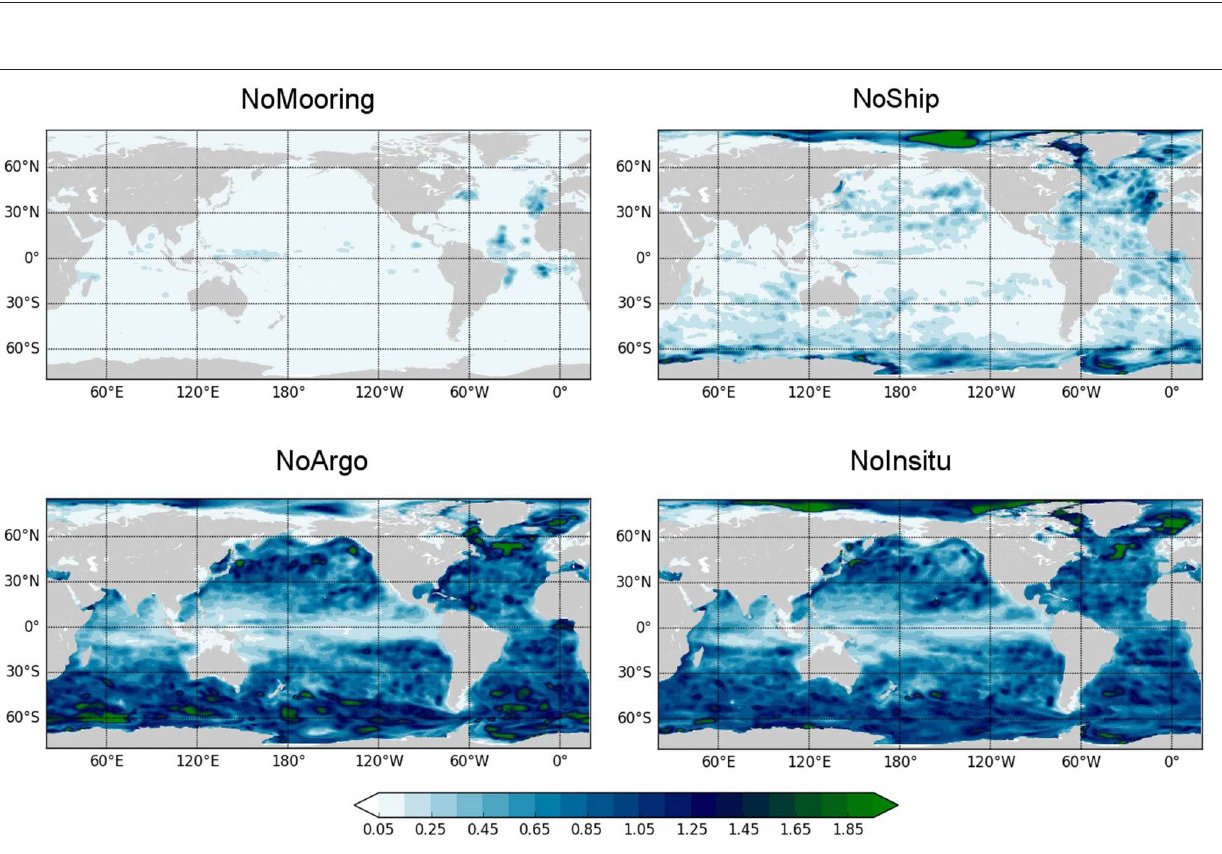
FIGURE 3 | Impacts of ocean observation data evaluated by OSE studies using the latest operational ocean reanalysis system in ECMWF. Plots of normalized RMS differences of upper 700-m column-averaged temperature between the control experiment, in which all in-situ observations are assimilated, and OSEs with removal of mooring data (NoMooring), XBT, MBT, and CTD data (NoShip), Argo data (NoArgo), and all in-situ observations (NoInsitu). Statistics are computed using monthly-mean anomaly data over the 2008–2014 period after removal of the seasonal cycle information, then normalized against the temporal standard deviation of temperature over the same period in the control